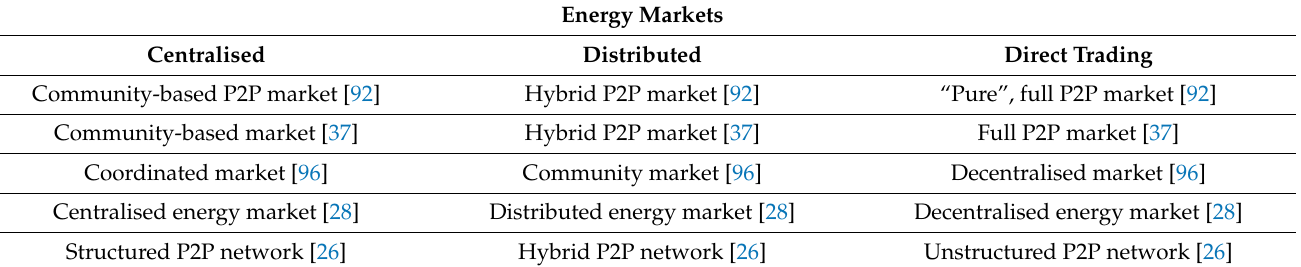
Figure 2. Division of P2P-ET derived from Section 2—Literature review. Table 6. P2P-ET market names in different literature